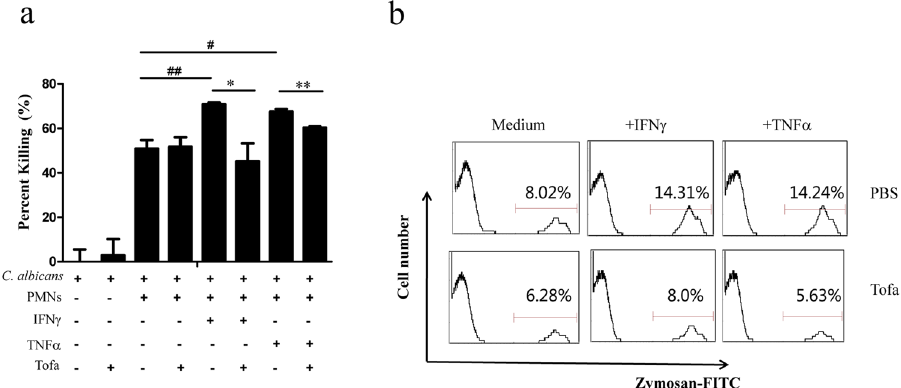
Figure 2. Inhibitory effect of tofacitinib on the candidacidal activity of mouse neutrophils. Freshly fractionated mouse neutrophils were pre-incubated with TNF α (200 U/ml) or IFN γ (10 ng/ml) in the presence, or absence, of tofacitinib (1 μ M) for 2 h. Viable C. albicans cells were then added to the cultures for fungal killing assays, with C. albicans cultured alone, or in the presence of tofacitinib, as controls ( a ). The results are expressed as percent killing calculated as 100 × (total CFU-survived CFU)/total CFU. ## p < 0.01, # p < 0.05, ** p < 0.01, * p < 0.05. For phagocytosis analysis ( b ), PMNs were further treated with zymosan-FITC for 30 min followed by FACS analysis. Results presented are representative of three independent